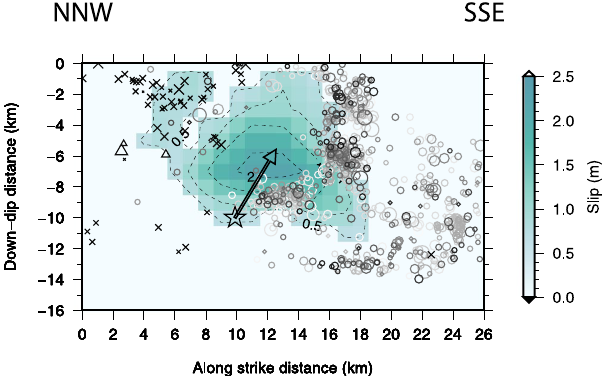
Figure 3. Dislocation associated with rupture of the Norcia 30 October 2016 earthquake 29,30 (see Methods). The preceding seismicity 29 since the 24 August 2016 Amatrice earthquake and occurring within 350 m (see Methods section) from the fault plane is also displayed. The colour code for time and symbols for aftershocks are the same as in Fig. 2. The foreshocks are distributed around the Norcia slip area – showing the “encircling maneuver” (ref. 24 ) leading to the breakage of the asperity – and are clustered in three main patches, with varying b -value representing a complex pattern of the differential stress, increasing down-dip and away from the asperity (Supplementary Fig. 2). The empty star corresponds to the location of the Norcia event hypocenter 29 (rupture nucleation), while the arrow indicates the dominant direction of rupture